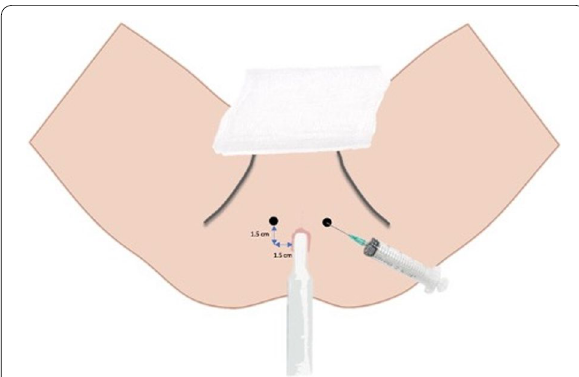
Fig. 4 Local anaesthetic and co-axial needle access points